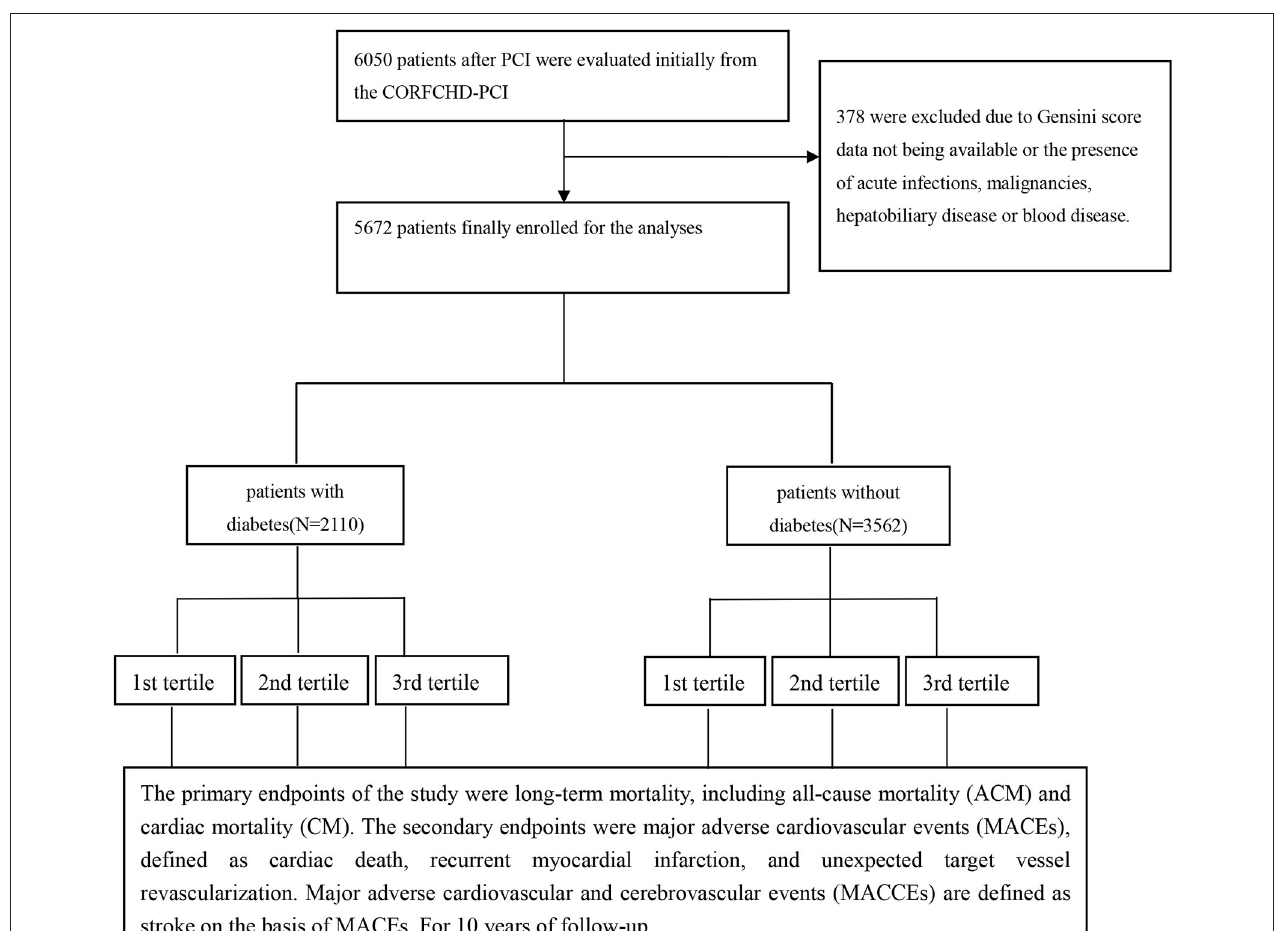
FIGURE 1 | The flowchart of participants’